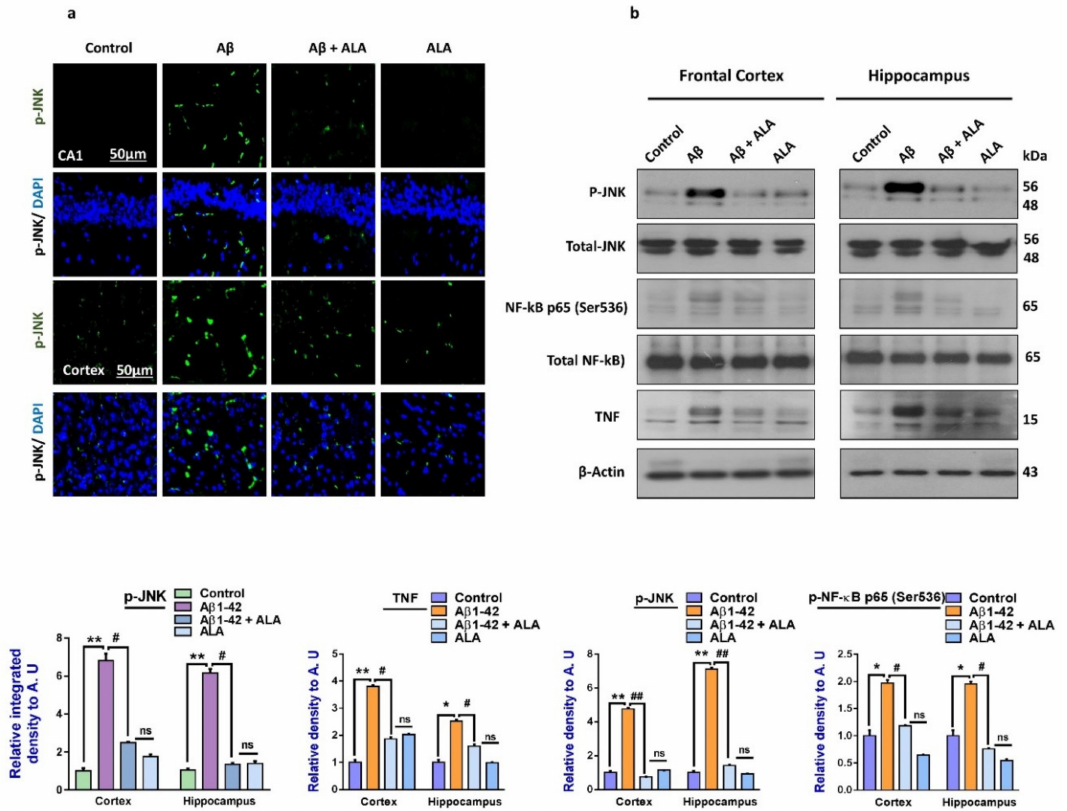
Figure 2. E ff ects of alpha linoleic acid against A β -induced activated p-JNK, p-NF-kB, and TNF- α in mouse brains. ( a ) Immunofluorescence results of p-JNK in the frontal cortices and hippocampi (CA1) of the treated mice groups ( n = 10 mice per group) with respective bar graphs. Magnification: 30 × ; scale bar 50 µ m. ( b ) Western blot results of p-JNK, p-NF-kB, and TNF- α in the experimental